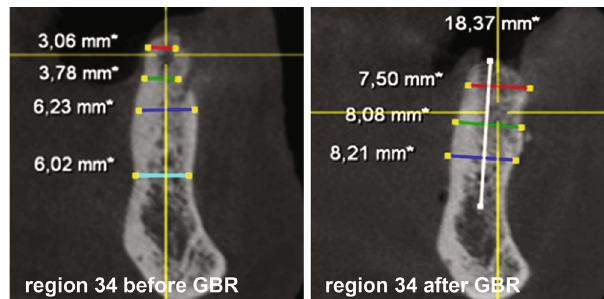
Figure 21: DVT — sections; implant position region 34 before and after GBR.